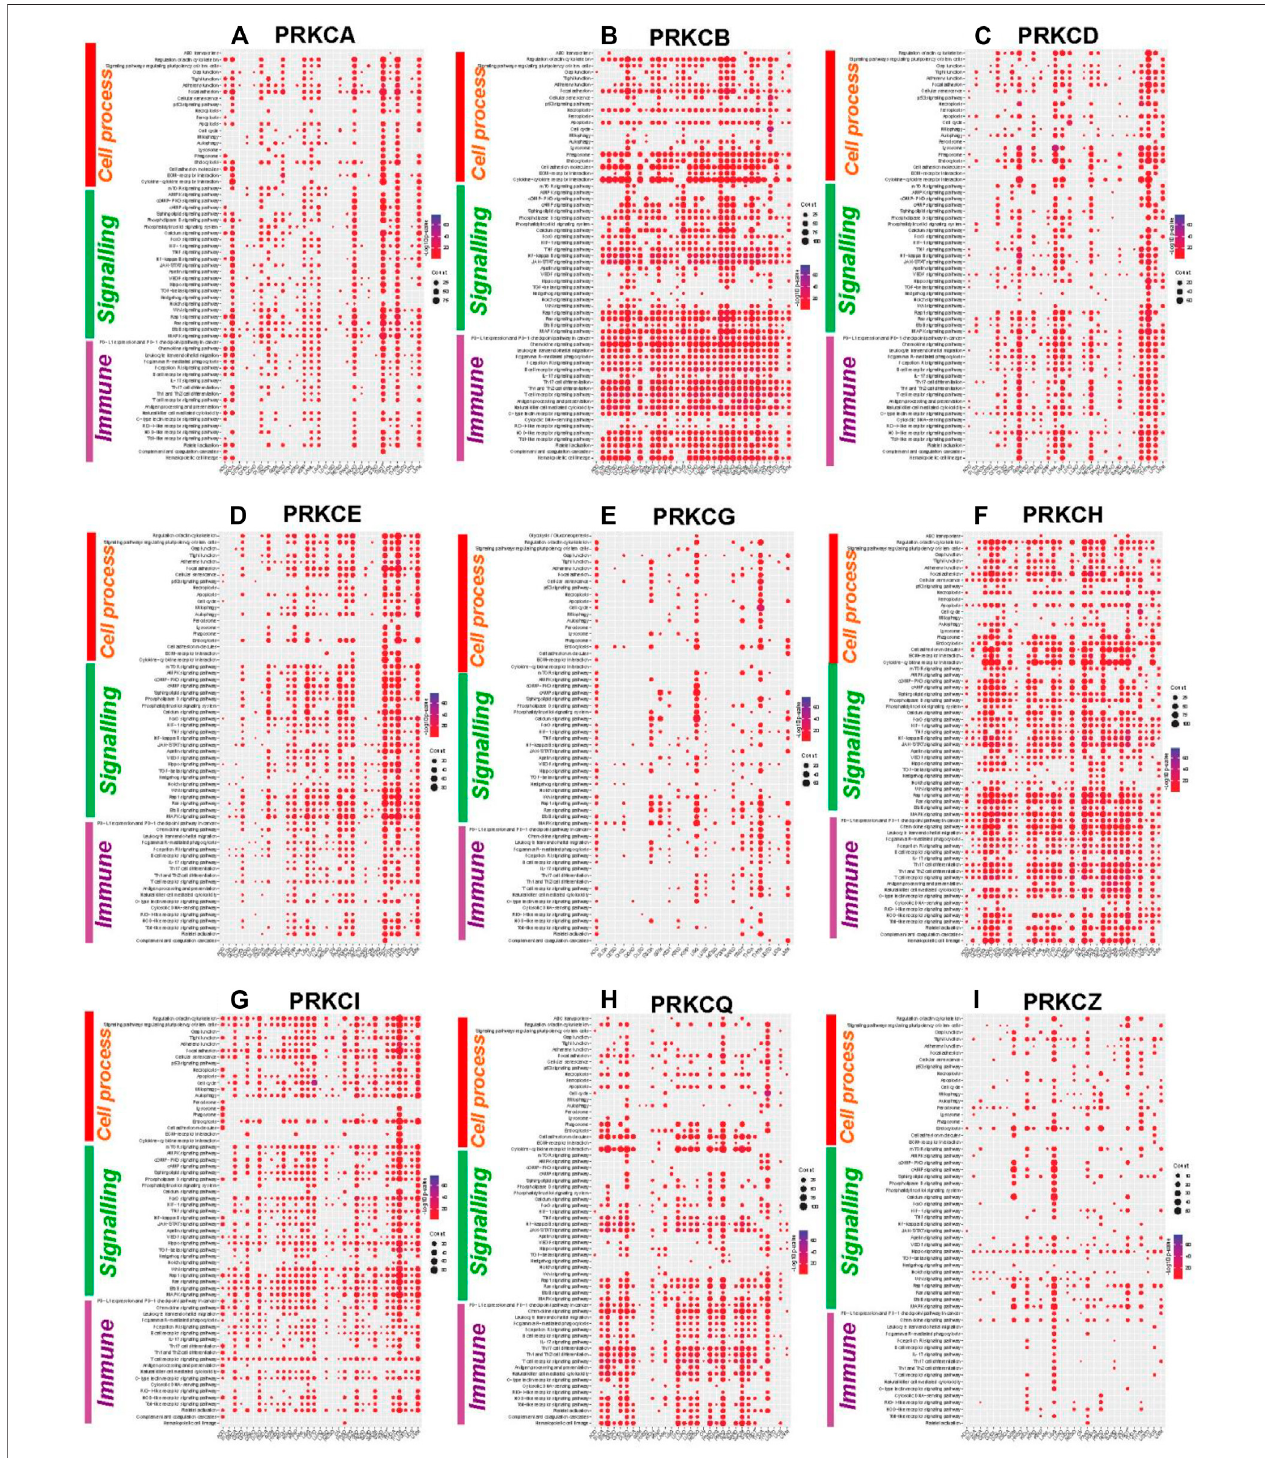
FIGURE 6 | KEGG pathways enrichment analysis of PKC signi fi cantly correlated genes in different cancers: PRKCA (A) , PRKCB (B) , PRKCD (C) , PRKCE (D) , PRKCG (E) , PRKCH (F) , PRKCI (G) , PRKCQ (H) , PRKCZ (I) . The dot size refers to the number of enriched genes in the pathway, while the color refers to the adjusted p